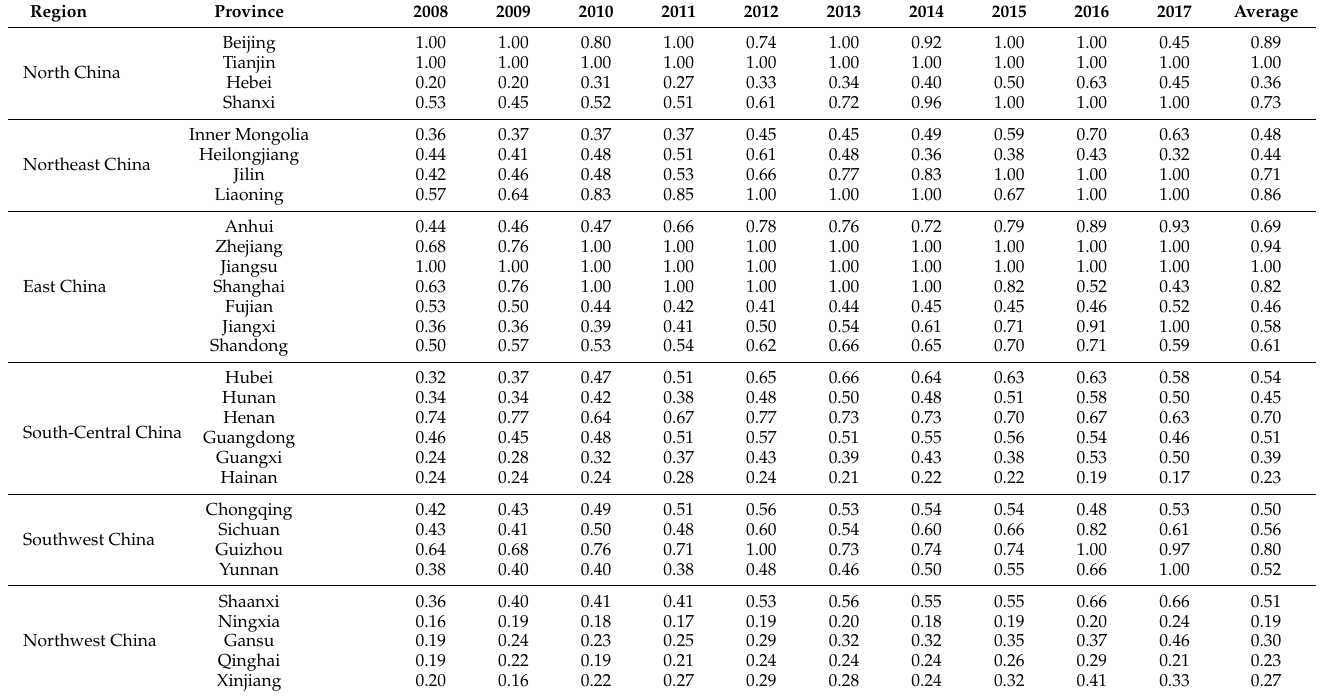
Table 4. Comprehensive eco-efficiency of China’s tourism industry (2008–2017).